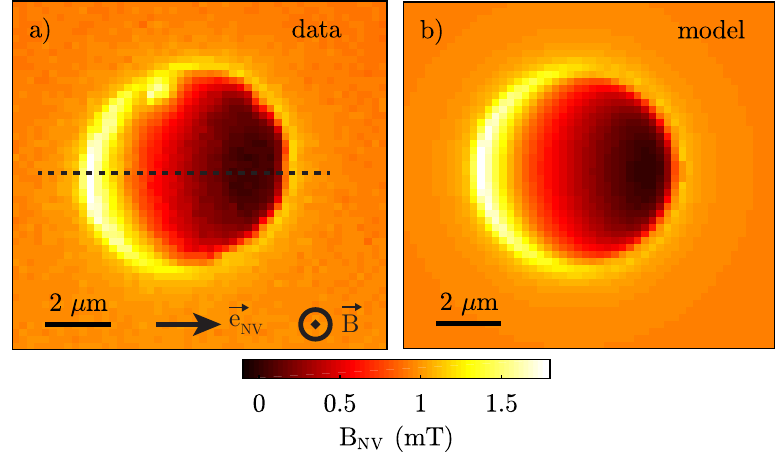
Figure 2. ( a ) Quantitative map of the magnetic field B NV , measured with the scanning NV spin above the YBCO disk in an external magnetic field of 1.7 mT applied perpendicular to the sample. Low magnetic fields are observed in the centre of the disk due to Meissner screening in the superconductor and maximal fields at the edges of the disk due to compression of the field lines expelled from the disk. The observed absence of rotational symmetry of B NV around the disk centre is a result of the NV orientation being away from the sample normal. The data were acquired with a pixel dwell-time of 12 s resulting in a scan time of 8 h for the entire scan. The green readout laser was set to a power of 350 µ W with a microwave power of ∼ 15 dBm sent into the cryostat. The dashed line indicates the position of the line scan in Figure 3. ( b ) Calculation of B NV using the numerical model described in the text, with λ = 250 nm and z NV = 100 nm as manually set input